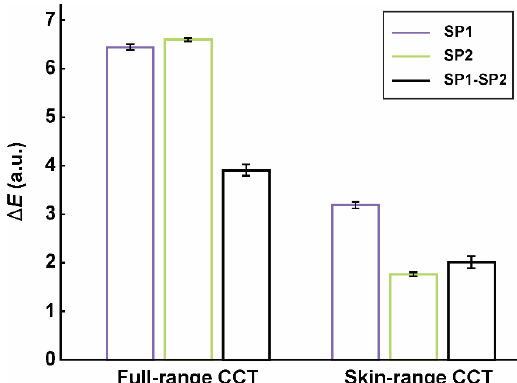
Figure 4. Mean CIE76 color differences ( ΔE ) with standard deviations as error bars for the full-range or skin-range CCT, obtained from the six image sets which were acquired by the first (SP1, Nokia) or second (SP2, Samsung) smartphone, respectively. SP1–SP2 marks the color differences between both smartphones’ estimates.